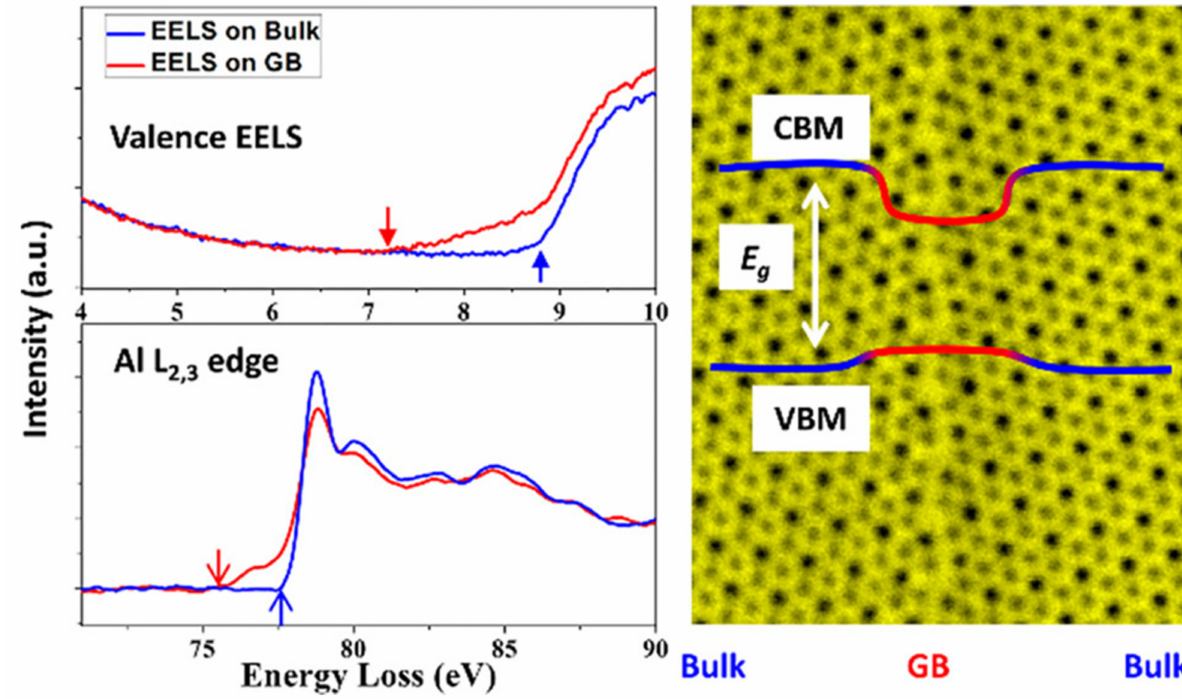
Figure 18. Valence EELS and Al-L 23 for bulk and GB. Difference between bang gap in the bulk and at the GB [161]. Reprinted with permission from Copyright © 2020 American Chemical